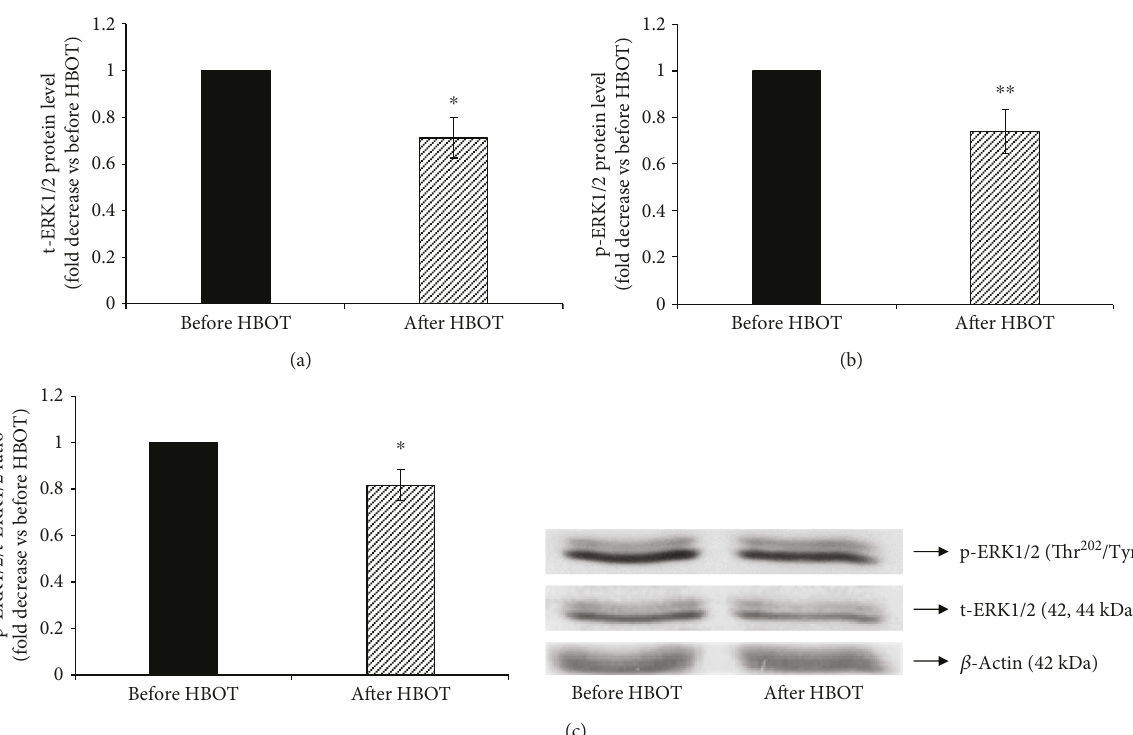
Figure 4: Phosphorylation of ERK1/2 at Thr 202 and Tyr 204 in lymphocytes after HBO exposure. (a) Level of t-ERK1/2 protein in lymphocytes, normalized to β -actin and expressed as fold change before HBOT (arbitrary control set at 1); (b) level of p-ERK1/2/(Thr 202 /Tyr 204 ) protein in lymphocytes, normalized to β -actin and expressed as fold change before HBOT (arbitrary control set at 1); (c) ratio of p-ERK1/2/t-ERK1/2 expressed as fold change before HBOT (arbitrary control set at 1). Inset: representative Western blots ( n = 14 ); ∗∗ p < 0 01 ; ∗ p < 0 05 ; p-ERK1/2: the phosphorylated form of extracellular signal-regulated kinases 1 and 2; t-ERK1/2: the total form of extracellular signal-regulated kinases 1 and 2. Other abbreviations are under Table